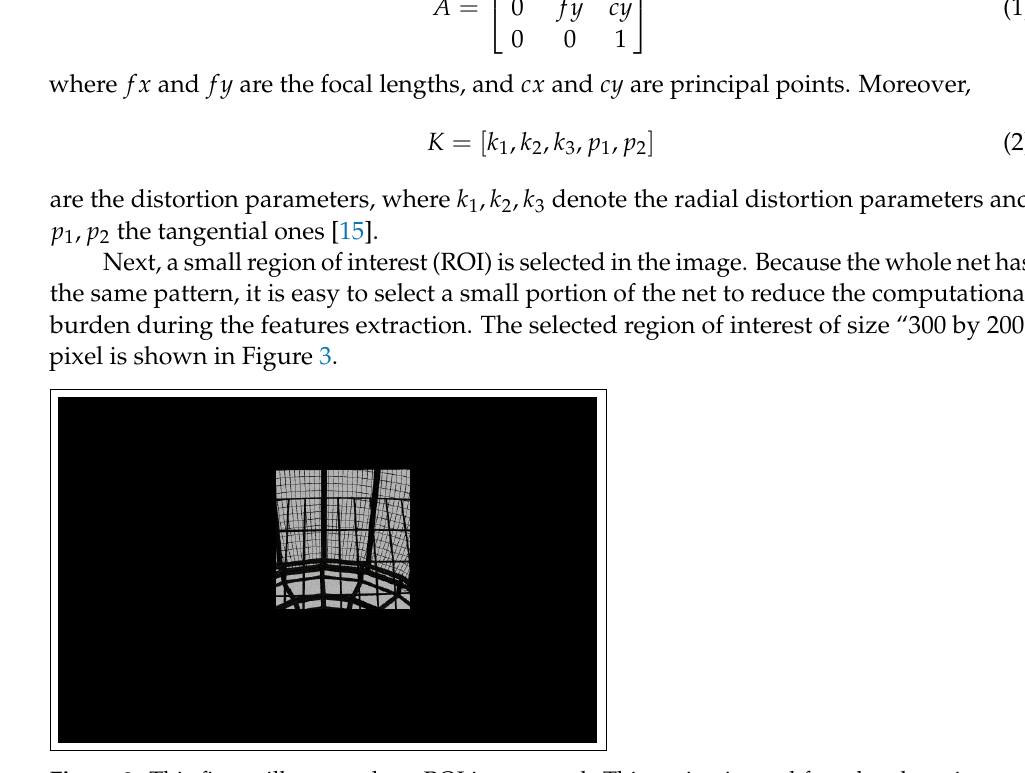
Figure 3. This figure illustrates how ROI is extracted. This region is used for edge detection and features extraction.